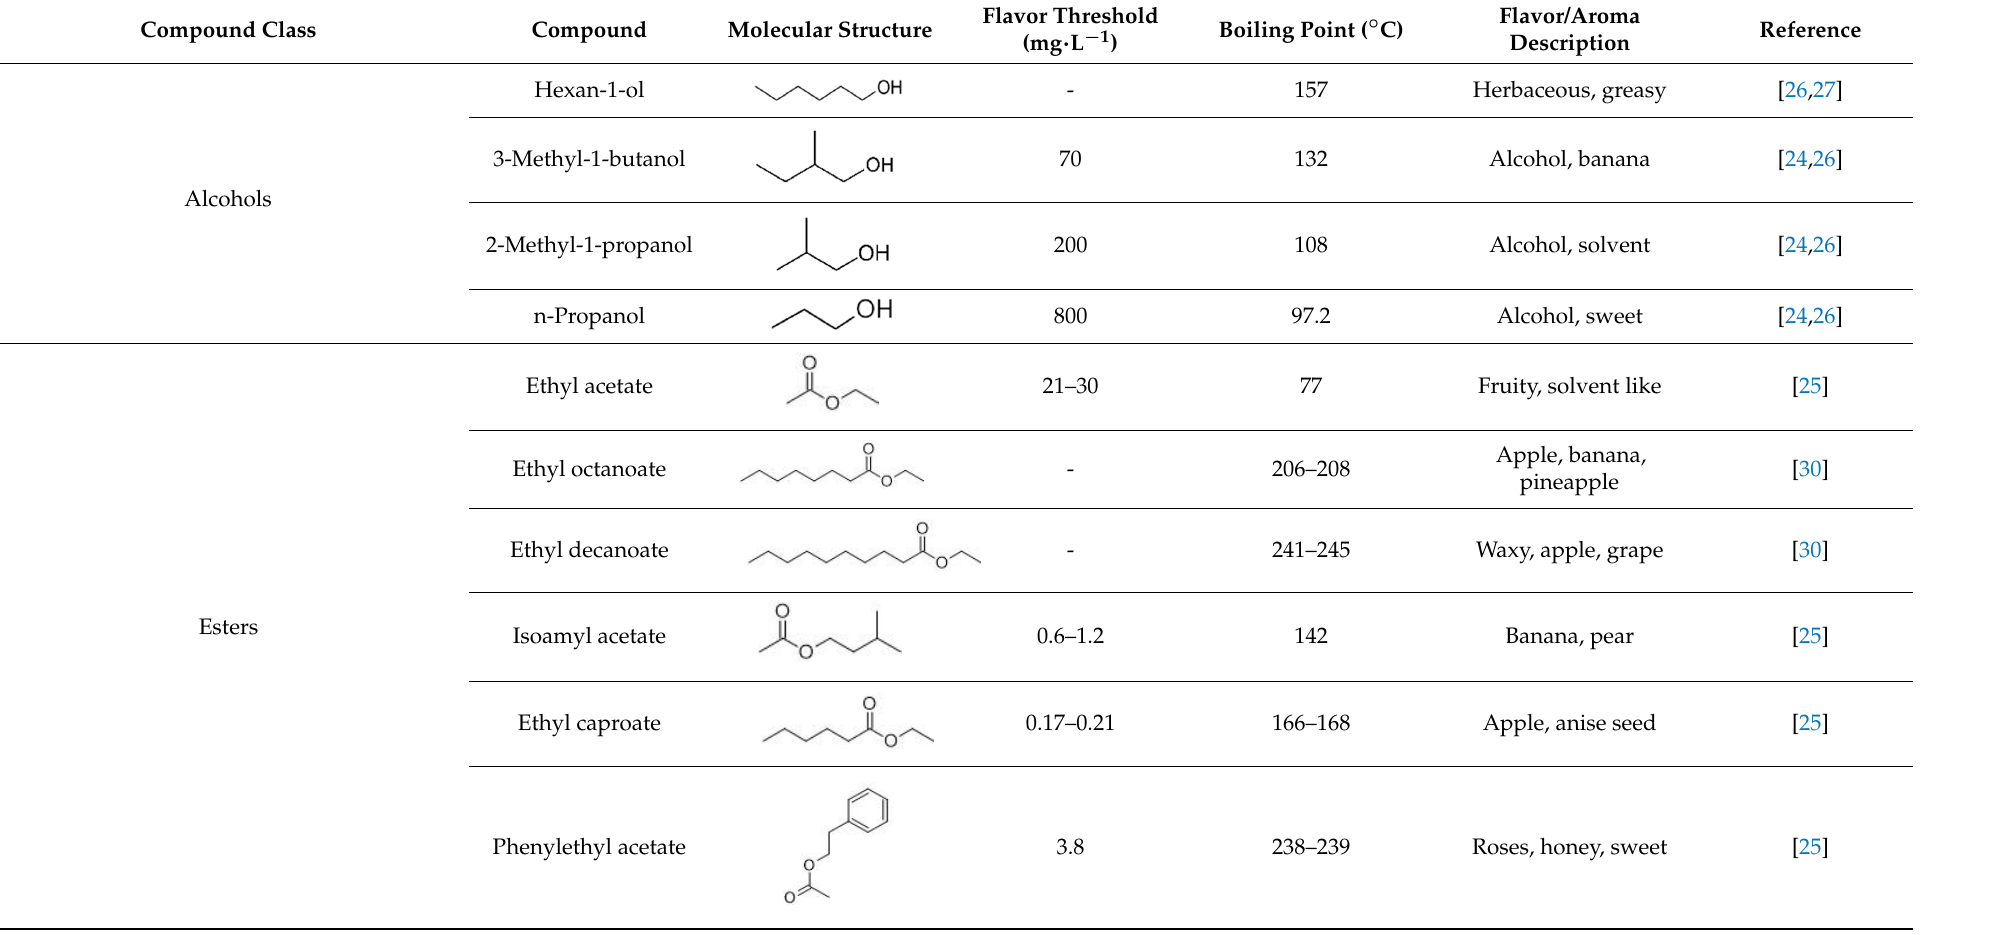
Table 2. Main classes of volatile compounds that contribute to beer flavor.